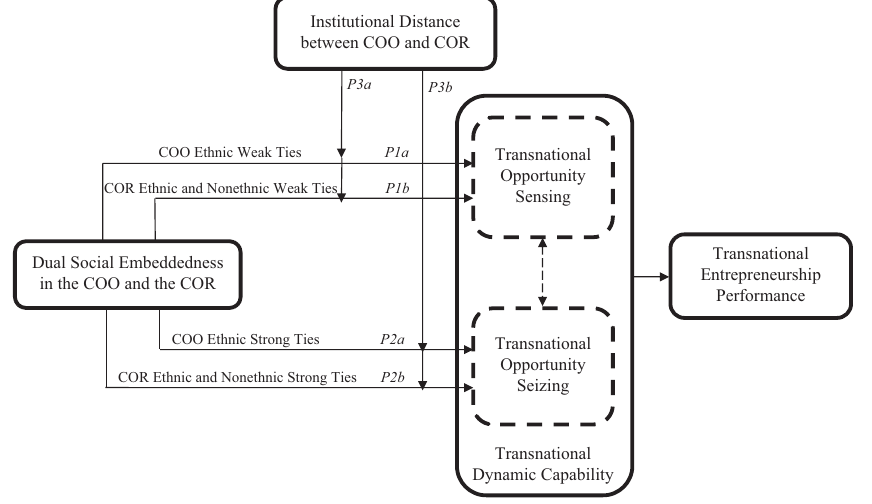
Figure 2. The theoretical